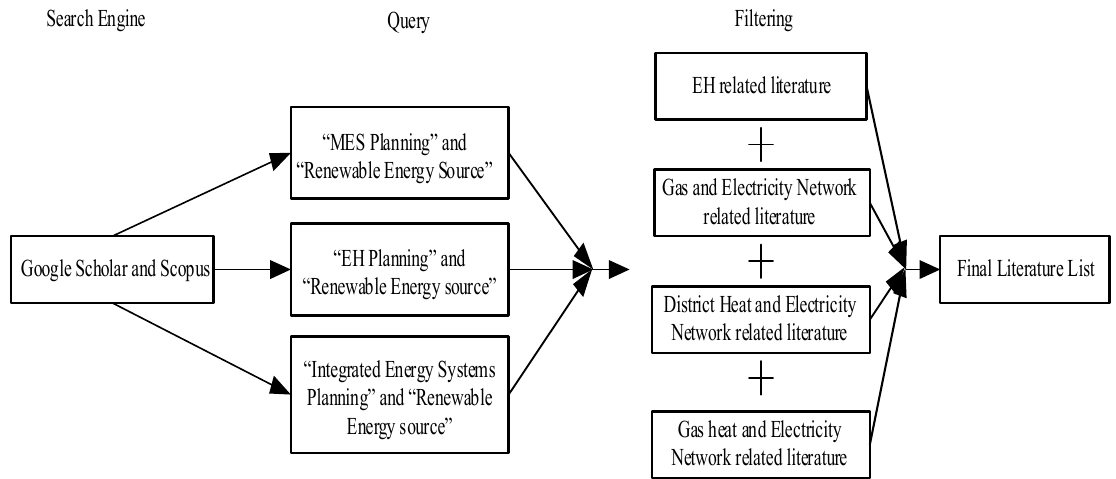
Figure 1. Methodology for finding suitable studies [36] .